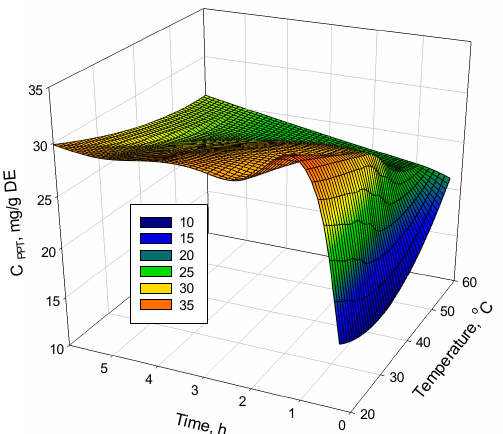
6 of 27 Figure 4. Effect of the extraction time on the PPT concentration in J. virginiana leaf extracts and correlation of Peleg’s equation curve (line) with the experimental data (points). Variable parame- ter—extraction time; constant parameters (previously selected conditions)—solvent ethyl acetate, room temperature and liquid-to-solid ratio of 10 ( v / w ). Abbreviations: PPT—podophyllotoxin; DE—dry extract.